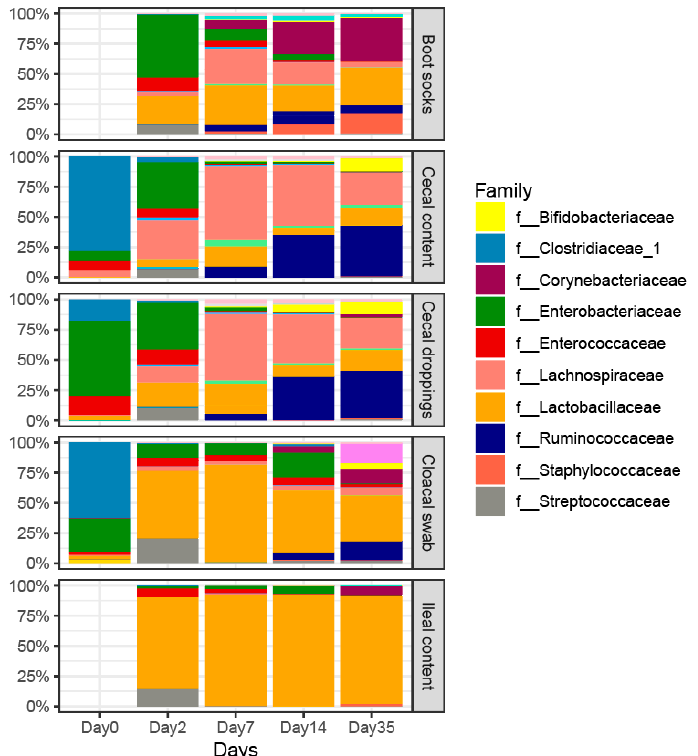
Figure 3. Relative microbial abundance across age and different sample types at family level. Only the labels of the 10 most abundant families are shown, the other families are not labeled for clarity. All families are presented in Table S2.